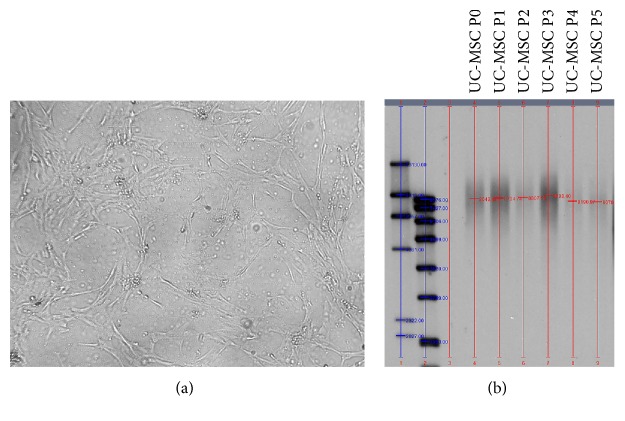
UC-MSC morphological characterization. (a) UC-MSCs at P1. Cells show a fibroblast-like morphology. Magnification 10x. (b) UC-MSC telomere length analysis at different passages (between P1 and P5); no difference is detected; n of samples = 4.